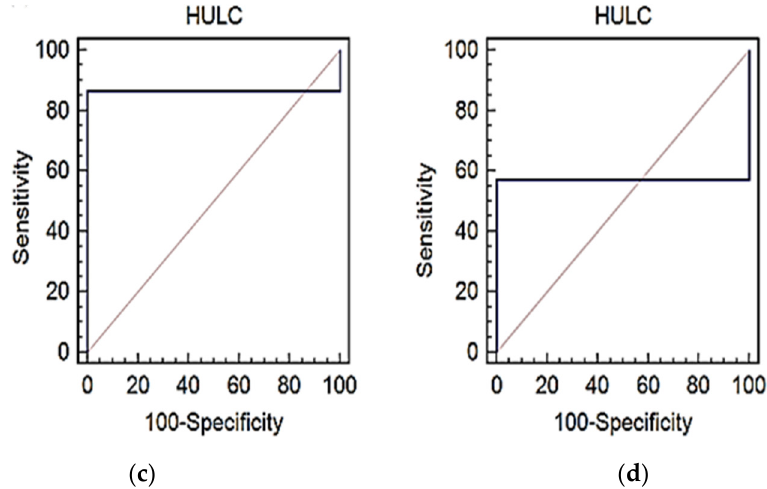
Figure 4. ROC curve analysis for miR-122 and HULC genes. ( a ) diagnostic performance of miR- 122 for HCV, best cut-off value = 8.16 [sensitivity = 96.8%, specificity = 98.9%, and accuracy 97.85%], area under the curve (AUC) = 0.997, 95% confidence interval = 0.989–1.00, p < 0.0001, ( b ) diagnostic performance of miR-122 for HCC, best cut-off value = 2.11 [sensitivity = 97.77%, specificity = 96.8%, and accuracy 97.29%], area under the curve (AUC) = 0.993, 95% confidence interval = 0.977–1.00, p < 0.0001, ( c ) diagnostic performance of HULC for HCV, best cut-off value = 16.25 [sensitivity = 84.2%, specificity = 99.1%, and accuracy 91.65%], area under the curve (AUC) = 0.847, 95% confidence interval = 0.684–1.00, p < 0.001, and ( d ) diagnostic performance of HULC for HCC, best cut-off value = 29.8 [sensitivity = 57.1%, specificity = 100%, and accuracy 78.55%], area under the curve (AUC) = 0.571, 95% confidence interval = 0.355–0.788, p = 0.05.